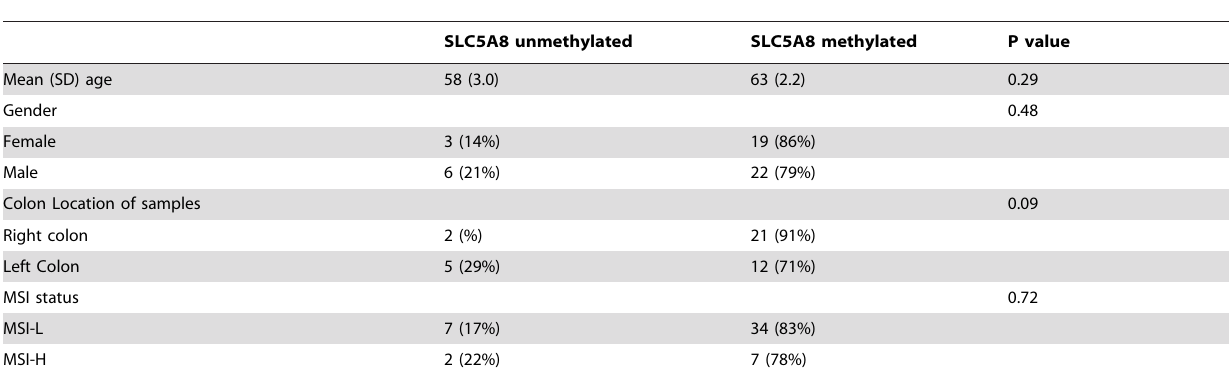
Table 1. SLC5A8 methylation and clinicopathological properties colon adenoma.